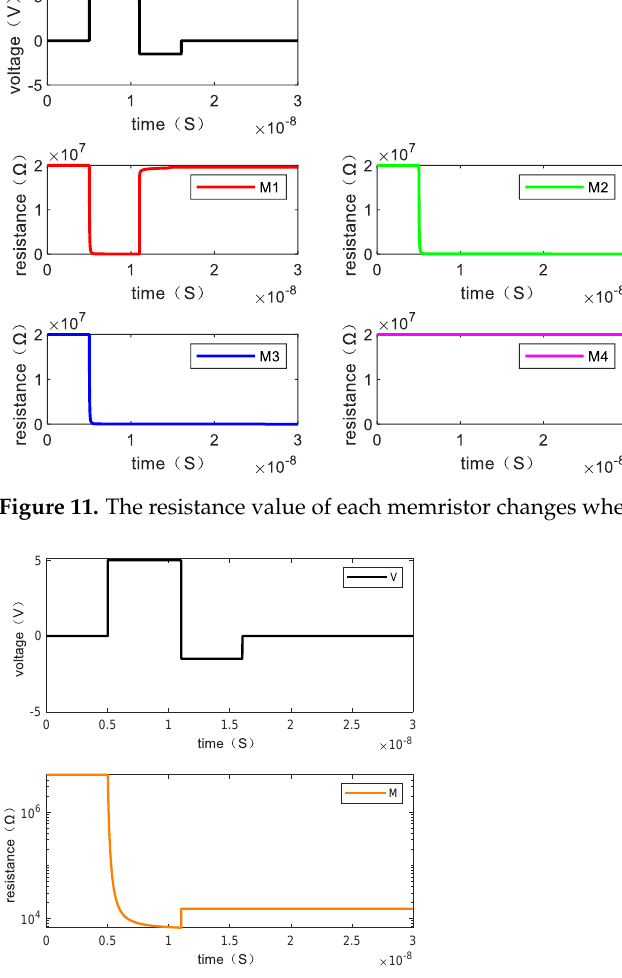
Figure 12. The changes of resistance value of the memory cell when writing